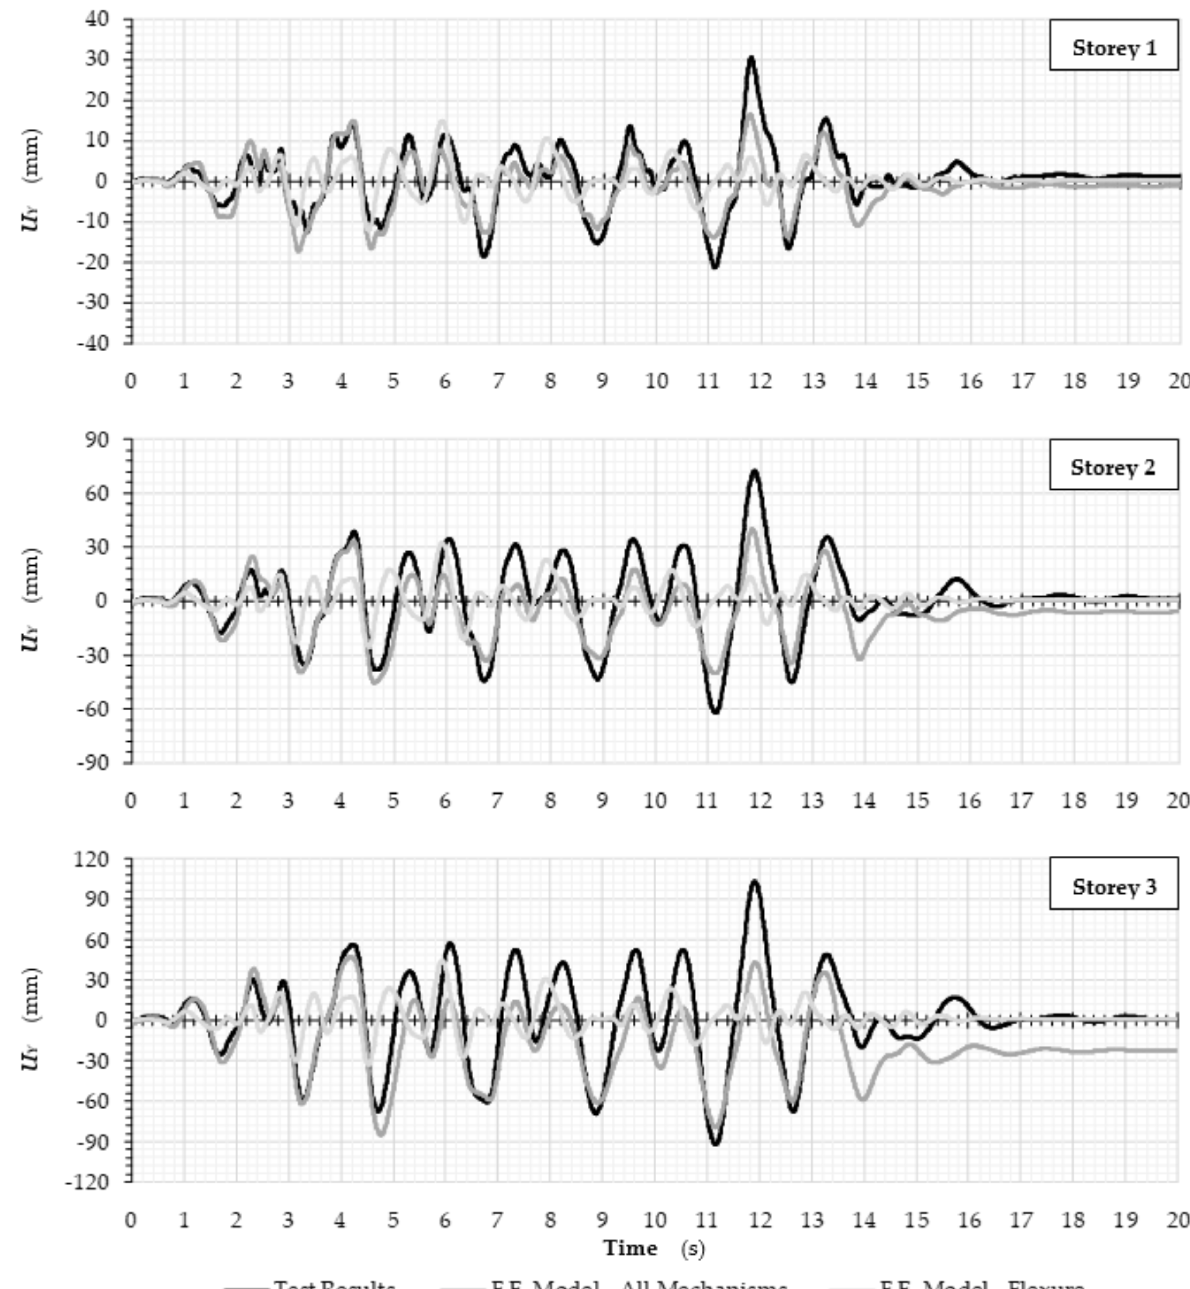
Figure 13. Comparison of the horizontal displacements in the Y -plan direction measured at the SPEAR building during the s12 earthquake case and the corresponding responses estimated from a dynamic analysis using two different FE building